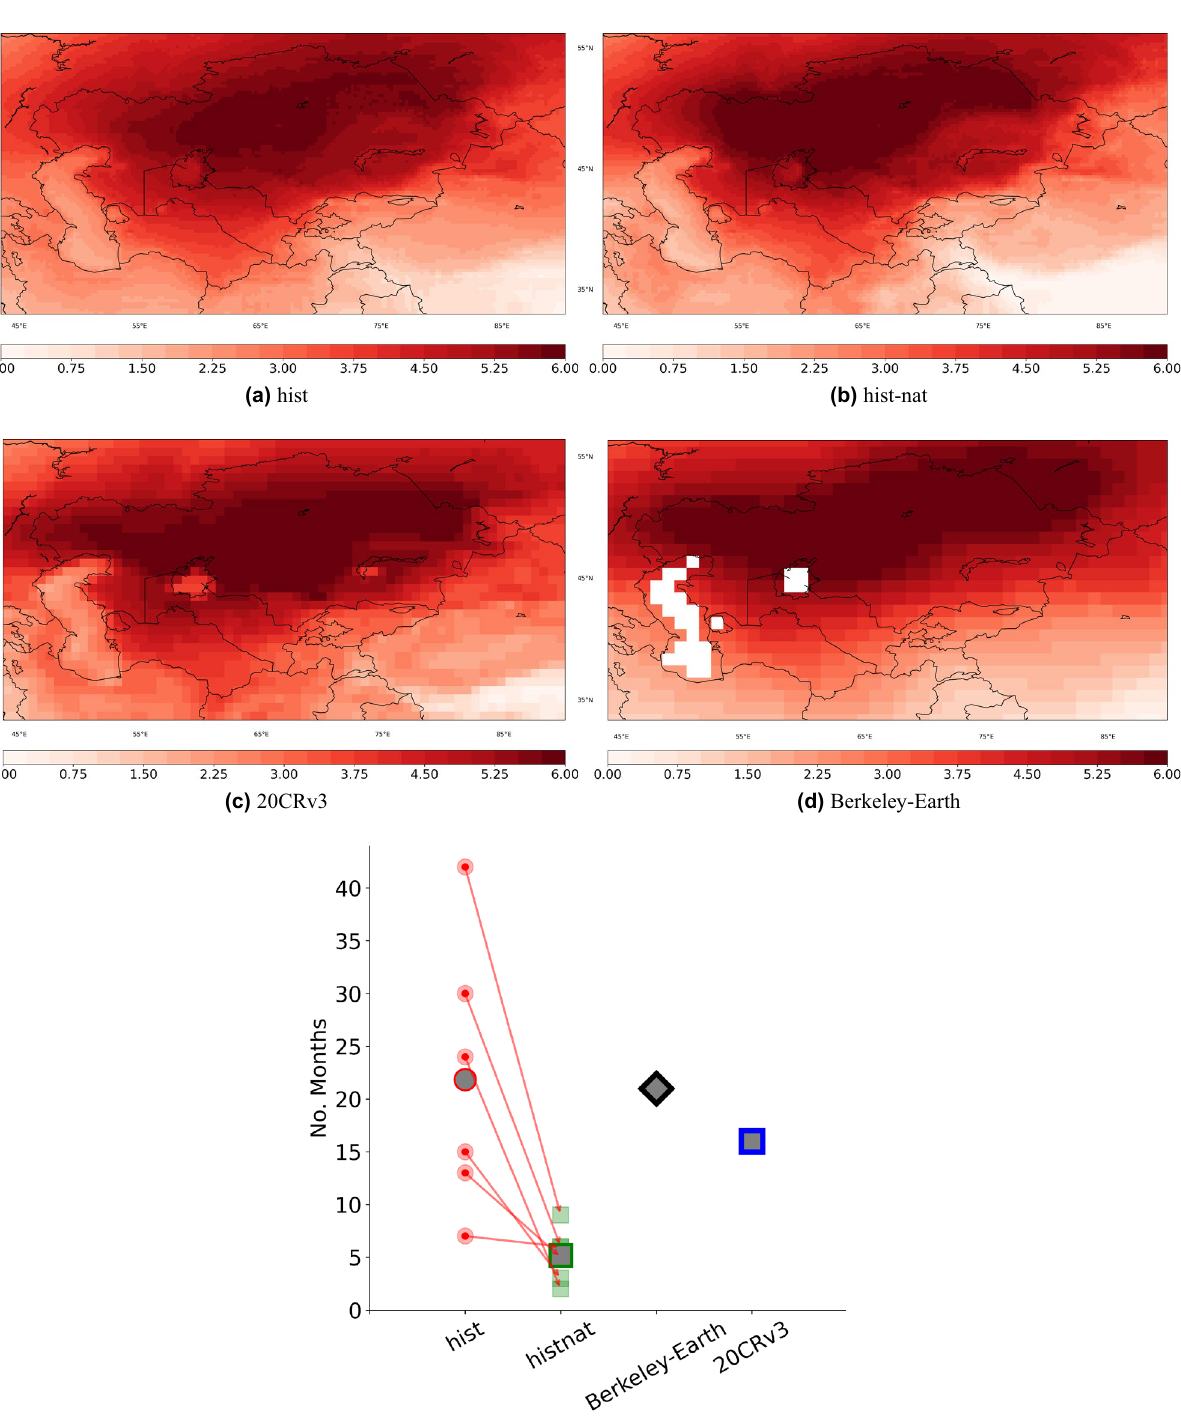
Figure 7. The mean temperature map for months with temperature anomaly greater than 3 K (1985–2014) from ( a ) hist , ( b ) hist-nat , ( c ) 20CRv3 and ( d ) same as in d but from the Berkeley observation data set. ( e ) shows the number of months detected with anomalies greater than 3 K for each data set. Ensemble mean of hist and hist-nat are shown by large circles and squares, respectively. The arrows connect the same models under different forcings. The maps were created using python3-matplotlib (version 3.1.2, https:// matpl otlib.